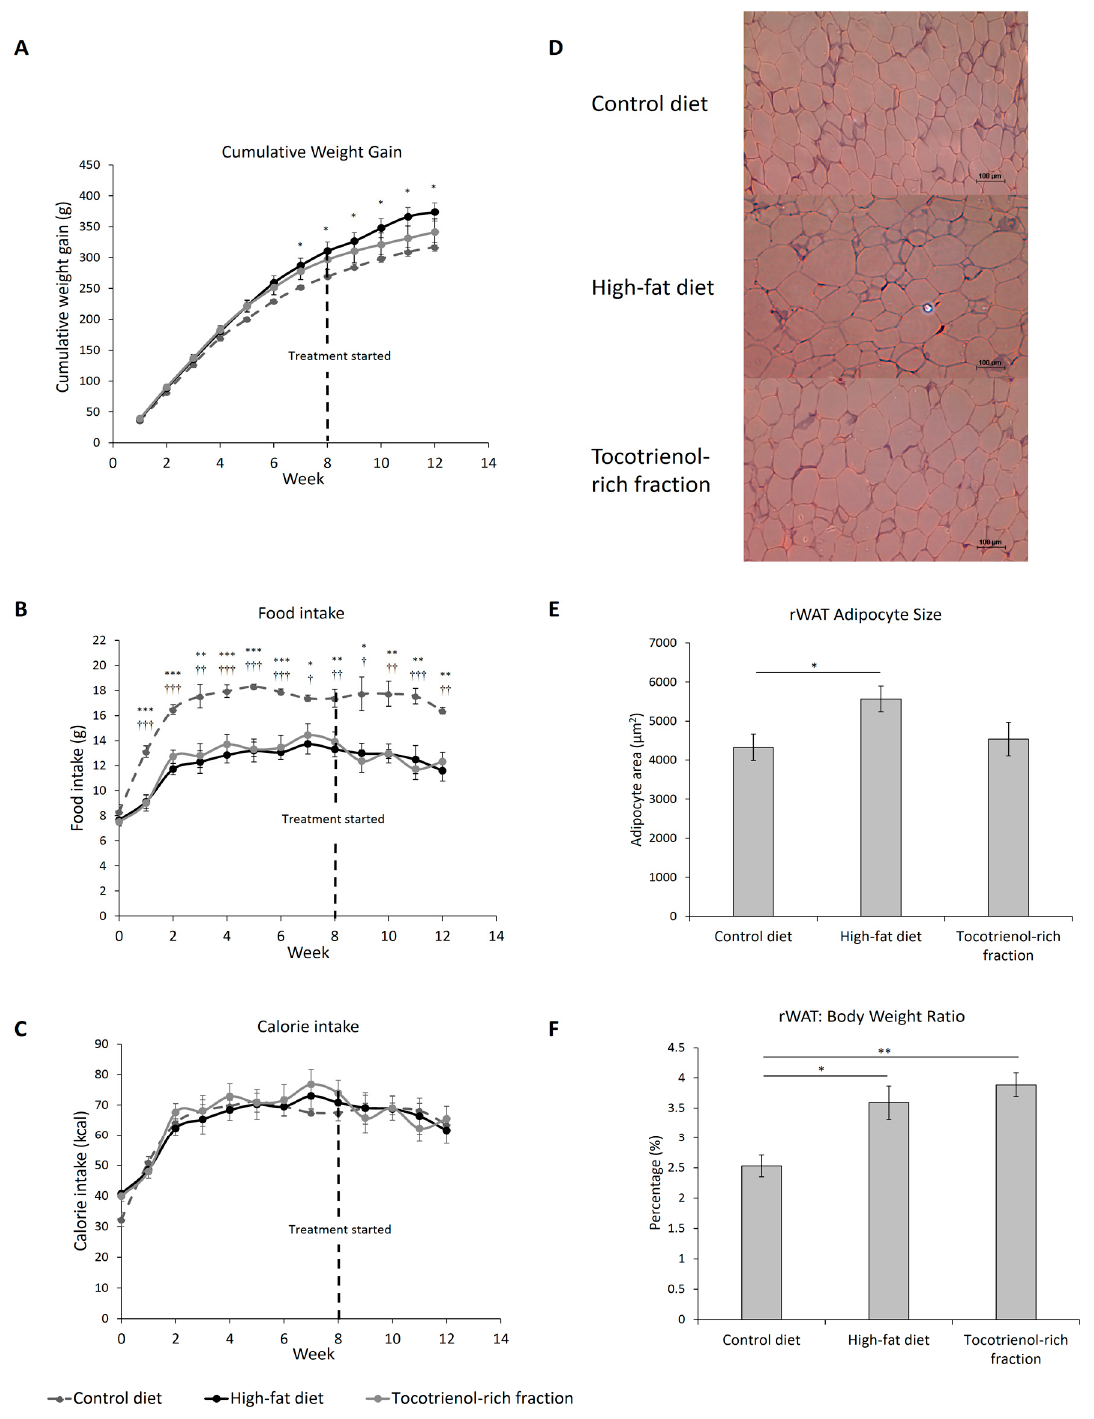
Figure 2. Cumulative weight gain ( A ), food intake ( B ), and calorie intake ( C ) of the rats assigned to different treatment groups. A tocotrienol-rich fraction was administered after 8 weeks of high-fat feeding, as indicated by the black dotted line. The representative images of the H&E-stained retroperitoneal white adipose tissues (×100 magnification) of each group are shown ( D ) and the average adipocyte areas are illustrated in bar plot ( E ). Retroperitoneal white adipose tissue weight-to-body weight ratio ( F ) was measured and expressed in percentage. Error bars indicate SEM. Sample size was n = 7 per group. For Figure 2A–C, *, **, *** indicate p < 0.05, 0.01, 0.001 between control and high-fat diet groups; †, ††, ††† indicate p < 0.05, 0.01, 0.001 between control diet and tocotrienol-rich fraction groups. For Figure 2E,F, * indicates p < 0.05 and ** indicates p < 0.01 between groups. rWAT: retroperitoneal white adipose tissue.